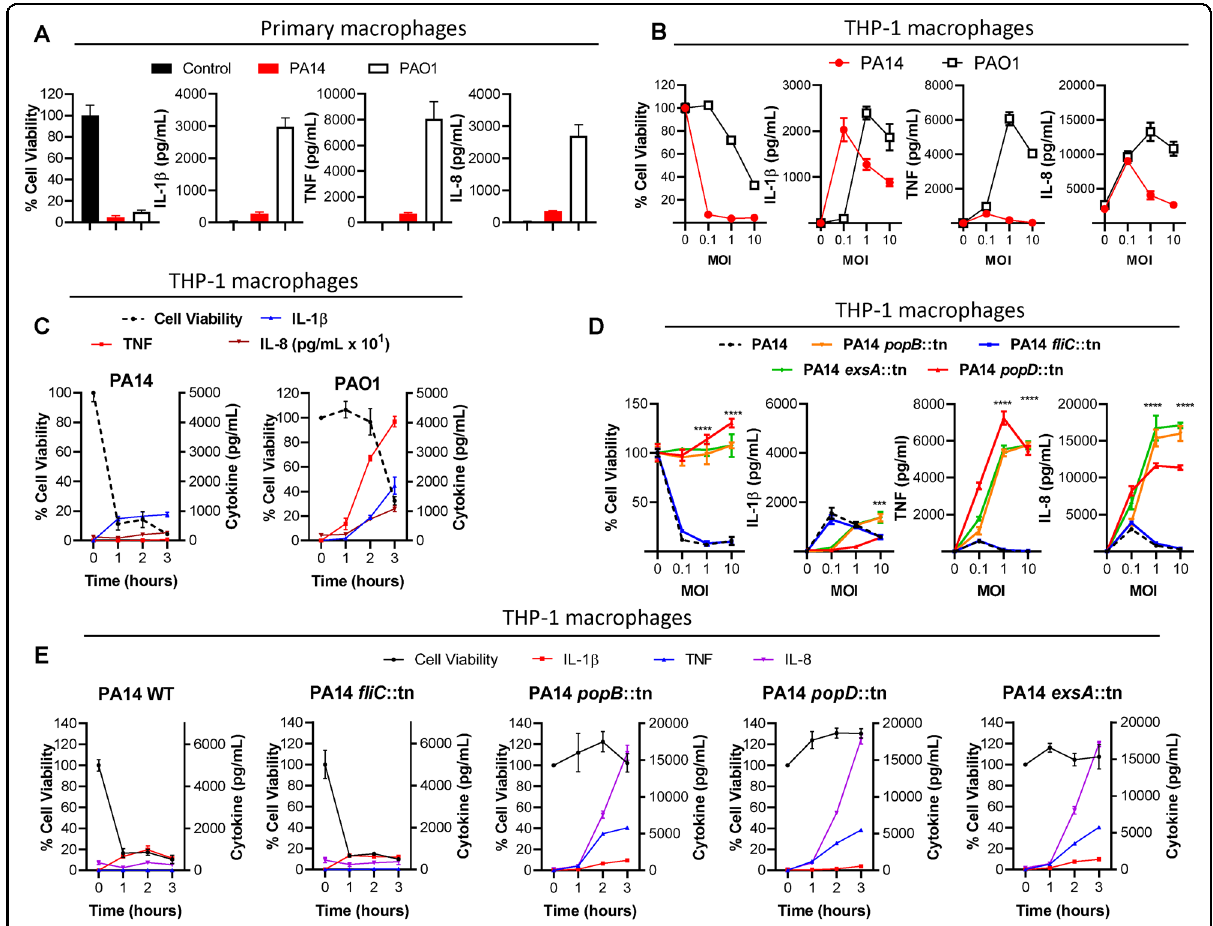
Fig. 6 PA14 mutants with impaired T3SS induce less cell death but higher expression of TNF and IL-8 compared to wild-type PA14. Primary human macrophages were seeded at 50,000 cells/well and infected with PA14 or PAO1 at MOI 10. Cell viability via neutral red assay and cytokine production via ELISA were measured 3 h postinfection ( A ). THP-1 macrophages were seeded as described in Fig. 1. In vitro infections were conducted with wild-type PA14 and PAO1, and the various transposon mutants ( fl iC ::tn, popB ::tn, popD ::tn, and exsA ::tn) of PA14. Cell viability was measured by neutral red assay and cytokine production was evaluated by ELISA at 3 h ( B , D ) or at 1-h intervals (MOI 10) ( C , E ). Mean ± SD of triplicates of a representative, or a pool of >3 experiments are shown. One-way ANOVAs were conducted to compare mean values at MOIs of 1 and 10. (**** P <